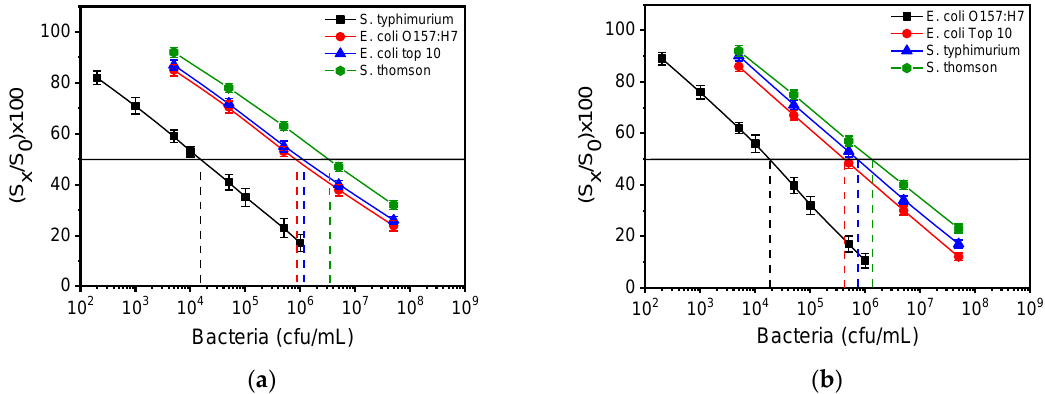
Figure 6. ( a ) Calibration curves for S. typhimurium (black squares), E. coli O157:H7 (red circles), E. coli top10 (blue triangles) and S . Thomson (green hexagones) obtained from MZIs spotted with S. typhimurium LPS. ( b ) Calibration curves for E. coli O157:H7 (black squares), E. coli top10 (red circles), S. typhimurium (blue triangles) and S. Thomson (green hexagones) obtained from MZIs spotted with E. coli LPS. The dashed vertical lines indicate the bacteria concentration that corresponds to a 50% signal drop with respect to zero calibrator (horizontal black line). Each point is the mean value of seven waveguides per chip ± SD.